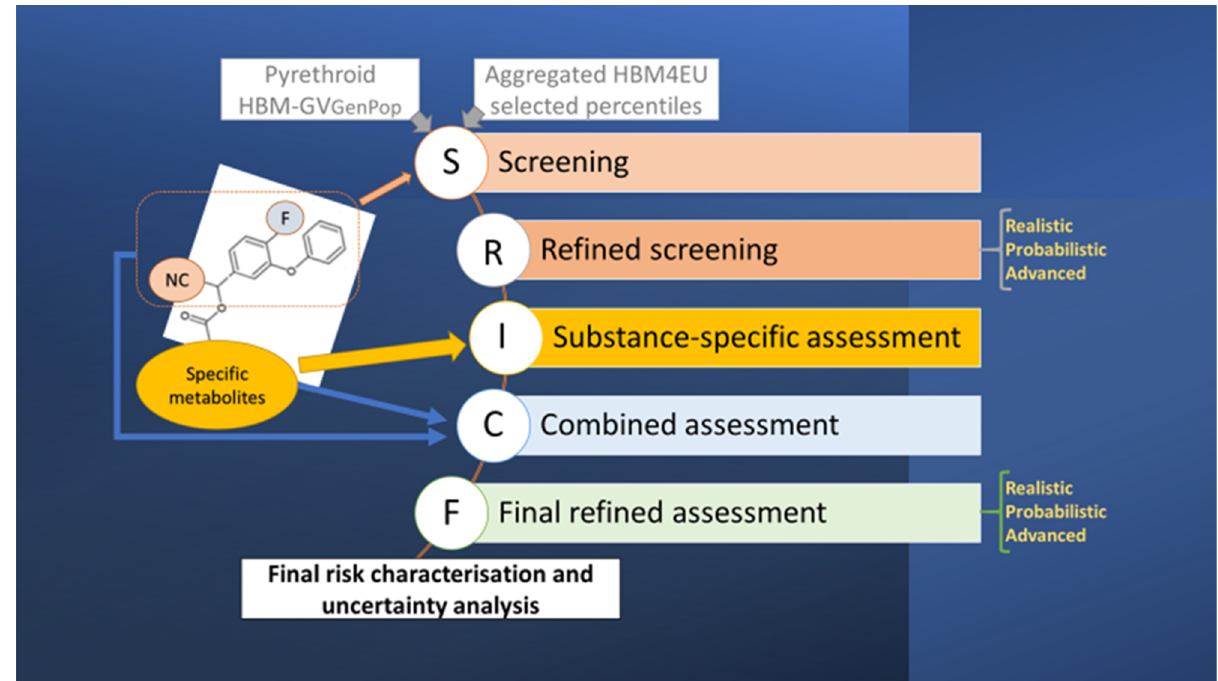
Figure 1. Conceptual model for the proposed tiered biomonitoring pyrethroid risk assessment ap-